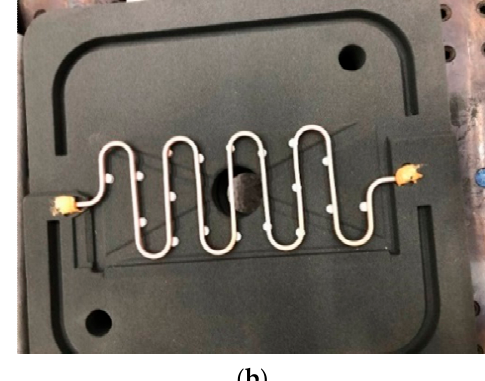
Figure 2. Core package made of 3D-printed sand, in two parts. ( a ) Top and bottom box assembled; ( b ) copper cooling channel positioned in the bottom box with the help of core blocks.